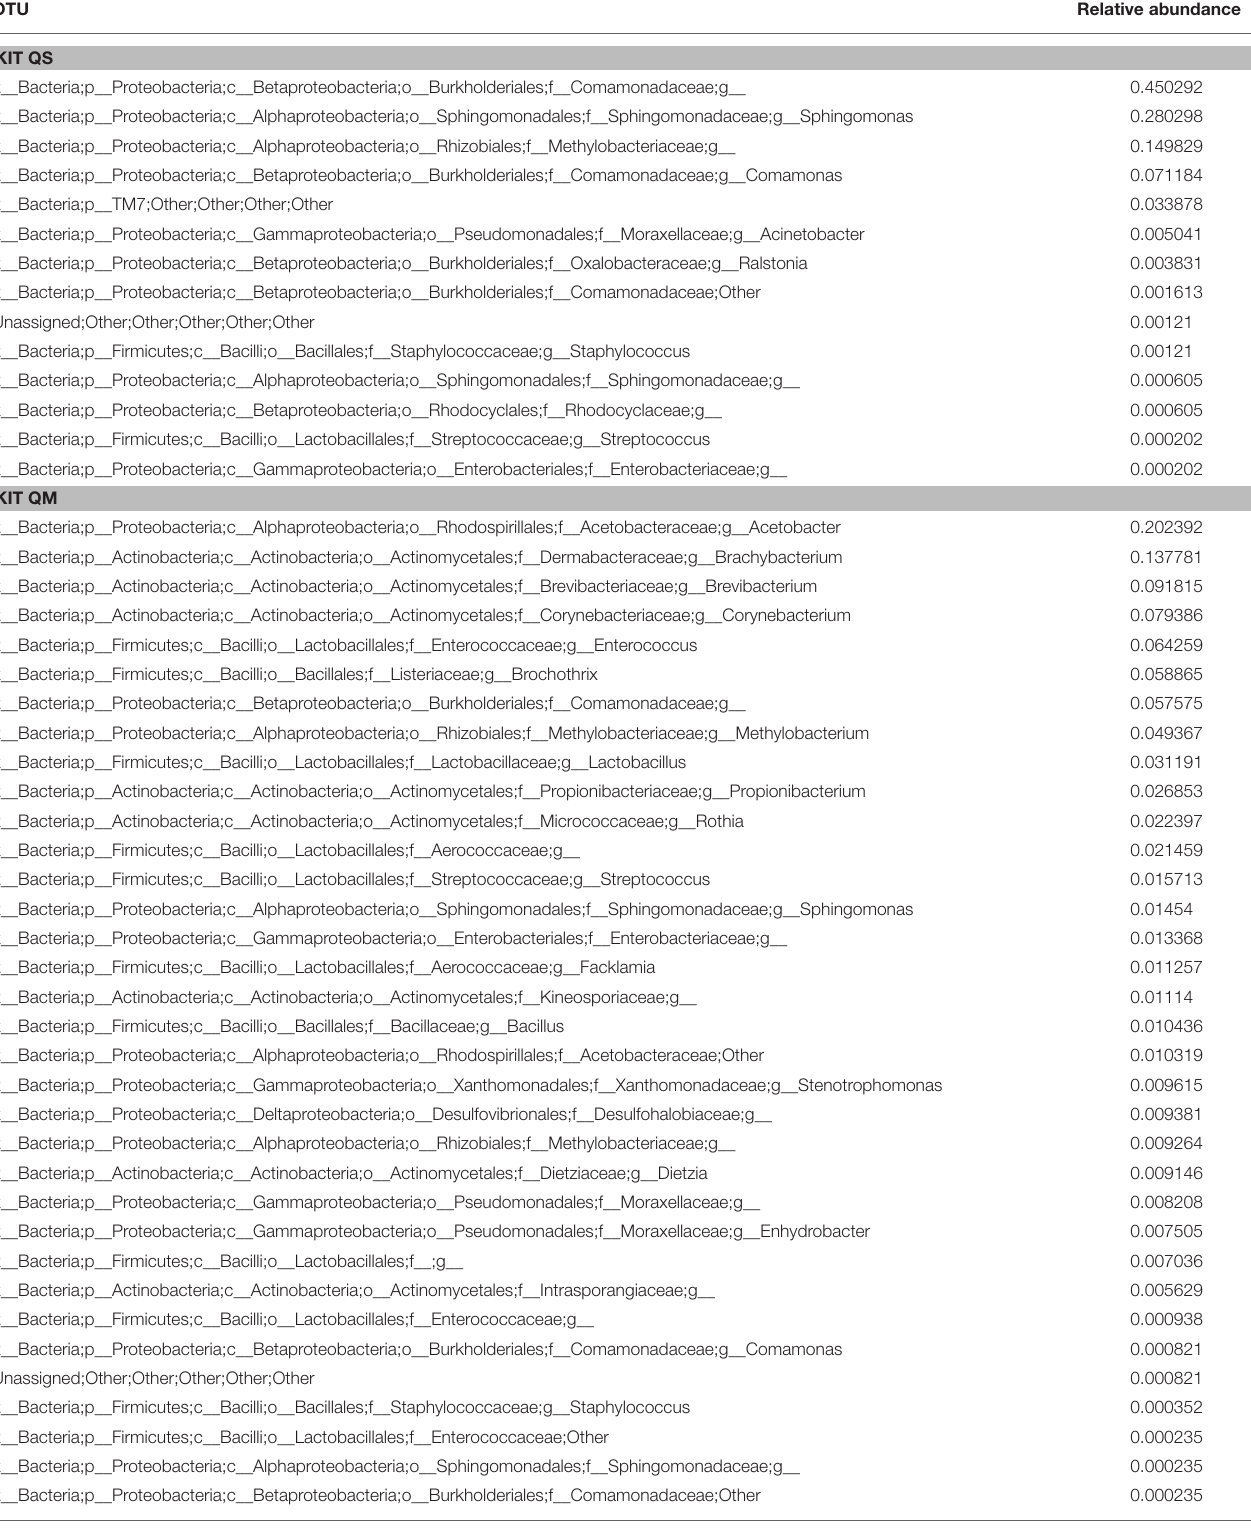
TABLE 2 | Summary of OTUs detected in negative extraction controls ( n = 1 per kit) and negative PCR controls ( n = 2). OTU Relative abundance KIT